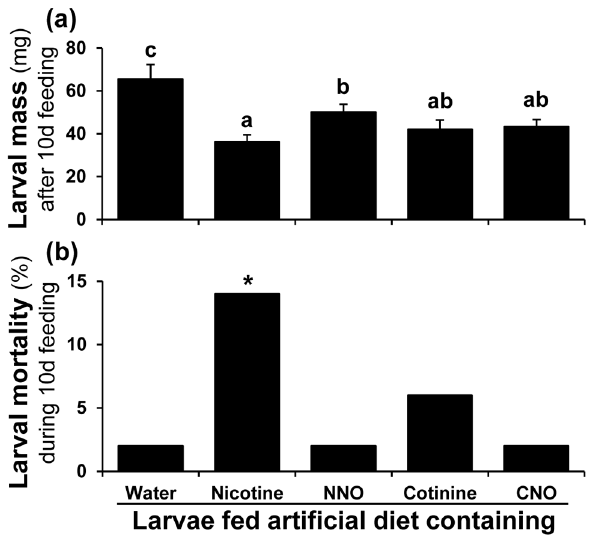
Figure 6. Nicotine is more toxic than the nicotine oxides to S. exigua larvae. ( a ) Larval mass of S. exigua [(mean 6 SE) F 4, 154 =6.03, P # 0.05, n=32, 27, 33, 30 and 33 for water, nicotine, NNO, cotinine and CNO, respectively] and ( b ) mortality (%) of S. exigua larvae during 10days of feeding artificial diet containing water (control) or 0.1% (fresh mass) nicotine, NNO, cotinine or CNO; each bar represents data from 30 larvae. In (a), lower-case letters above the bars indicate significant differences ( P # 0.05) by one-way ANOVA; in (b) asterisk indicates significant differences ( P # 0.05) in frequencies (and displayed percent- ages) by Fisher’s exact test.